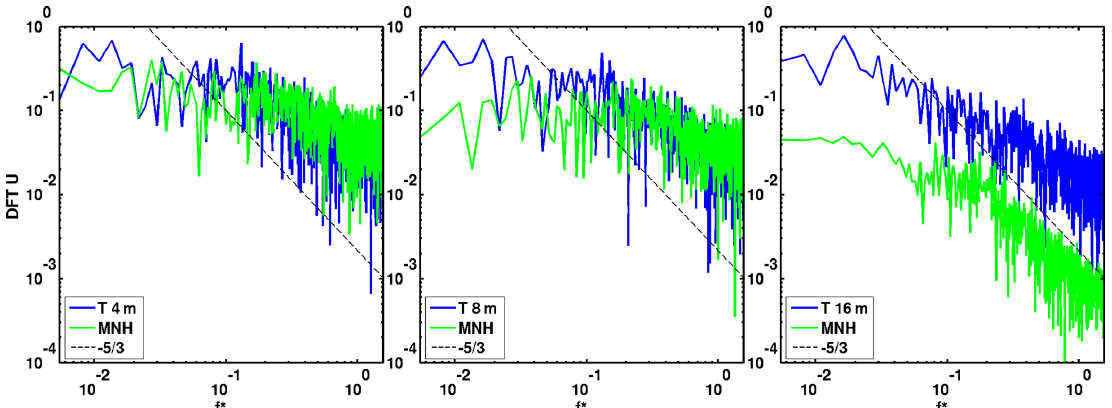
Figure 19. Spectrum of the measured (blue line) and modeled (green line) u wind component at the T tower at z = ( 4 ; 8 ; 16 ) m. f ∗ is dimensionless as a Strouhal number using | u | inlet ( z = 2 . 5m), and z = 2 . 5m is the container